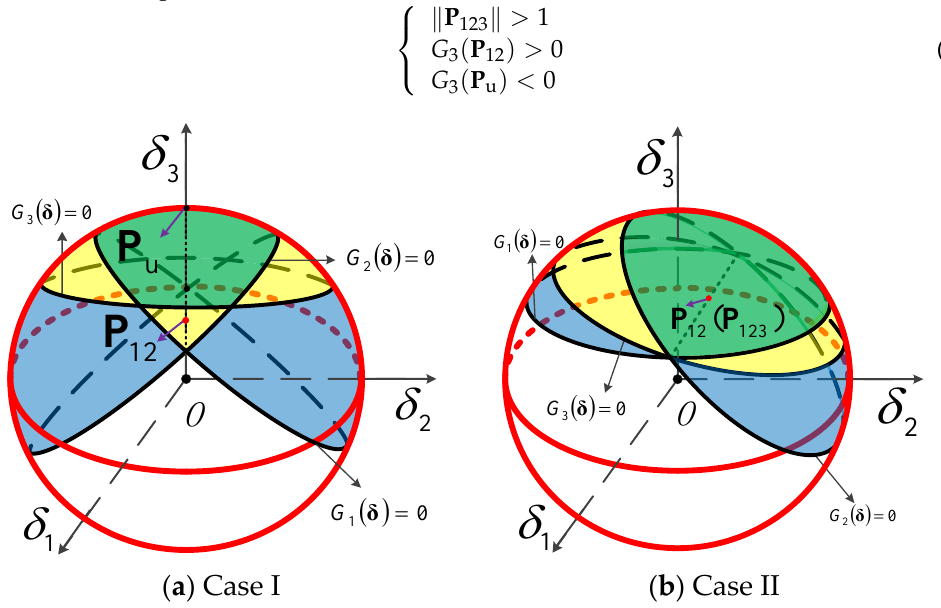
Figure 4. Two different cases of a subsystem with three failure modes: ( a ) Redundant failure mode general case. ( b ) Redundant failure mode critical case.